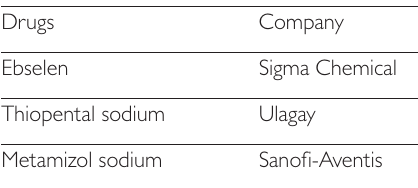
Anti-inflammatory